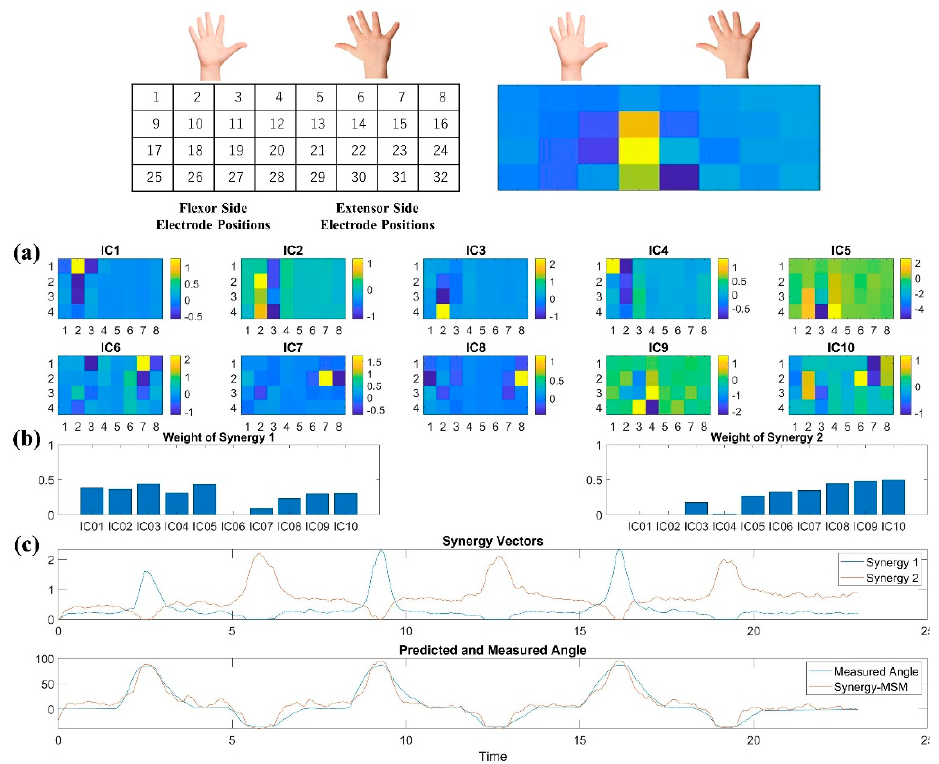
Figure 8. Post hoc analysis for the best model of Subject 7. ( a ) Topology Plot of IC weight, the yellow locations denote motion-related regions to muscle. ( b ) Synergy weight patterns and synergy vectors of Subject 7 in the task. The blue-colored line represents the flexion motion, and the red-colored line represents the extension motion. ( c ) The extracted muscle synergy was found to be highly correlated with the motion by comparison with the measured joint angles. At the top of figure shows the correspondence between hand anatomy and the position of IC.